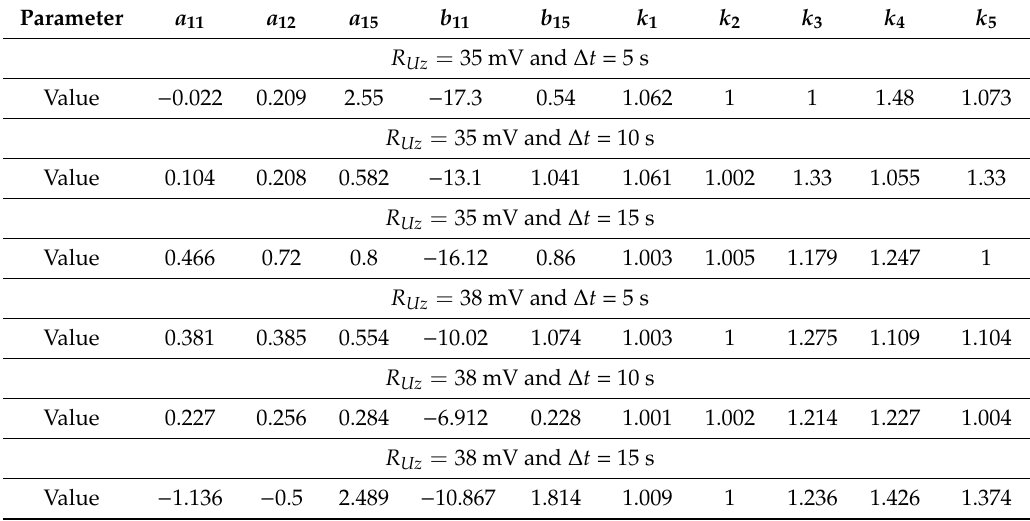
Table 7. Parameters of fuzzy logic controller determined using